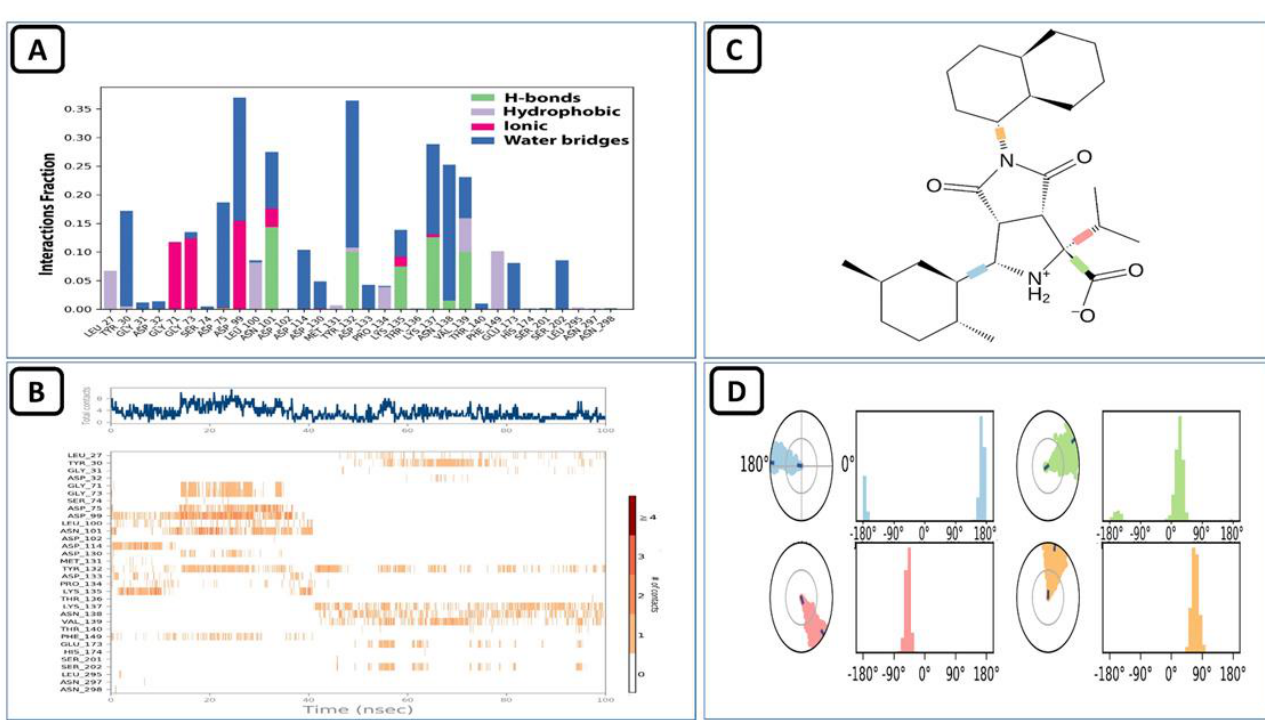
Figure 15. ( A ) Shows the protein-ligand interaction types, ( B ) shows the intensity of the interactions, ( C ) shows ligand torsions, and ( D ) shows the degree of the ligands rotatable bonds or